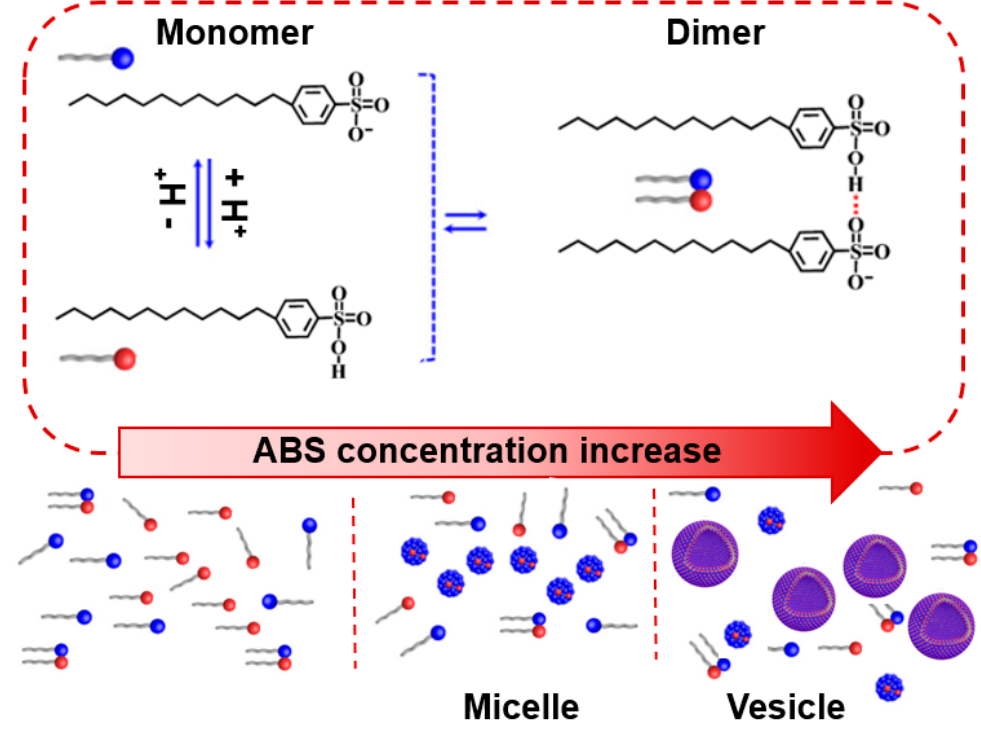
Figure 3. ABS surfactant forms and mechanism of ABS adsorption in the aqueous solutions. The surfactant aggregation is also greatly influenced by the properties of solvent and coexisting ions. Knowledge about the CMC and the behaviour of surfactants in the hy- drochloric acid medium and the presence of heavy metal ions is essential. Finally, anionic surfactants are used to support the removal of metals from wastewater and soil [7,43]. From the results shown in Figure 2 it was found that the presence of both metal ions and HCl changed the CMC values. Regardless of the metal ions, the CMC values in ABS